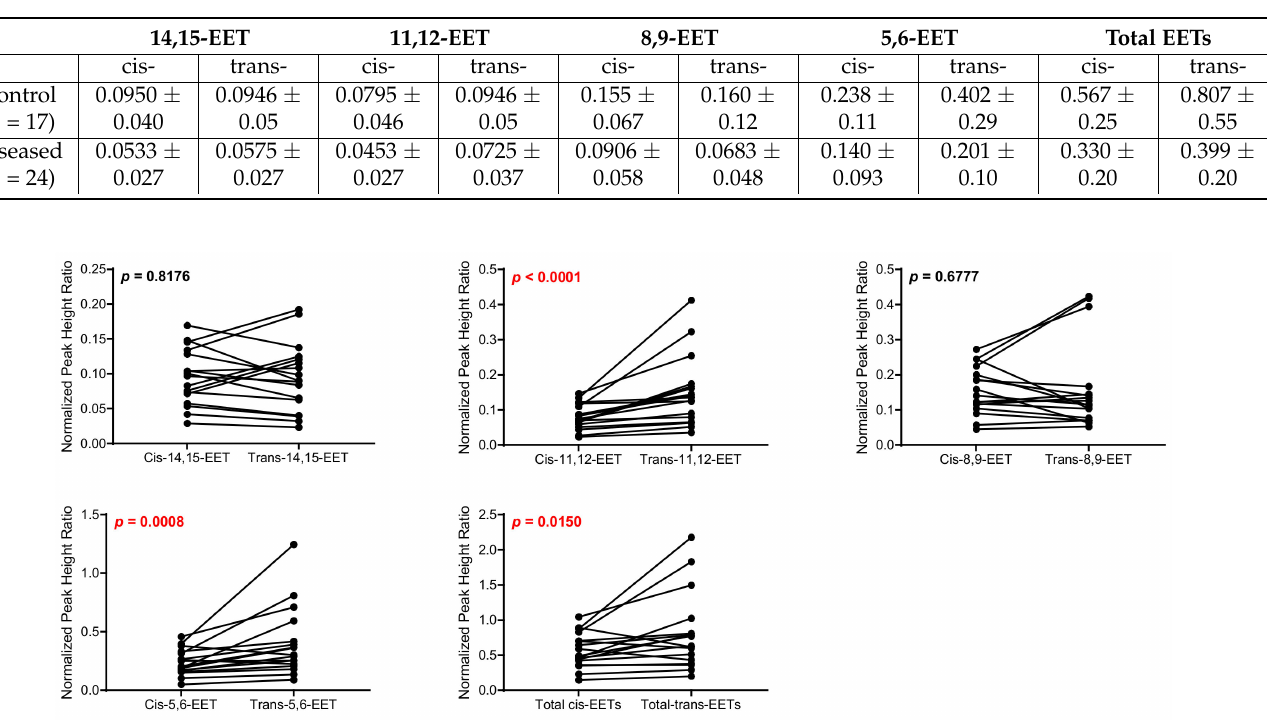
Table 2. Peak heigh ratios of cis - and trans -EETs in control and diseased human heart tissues.